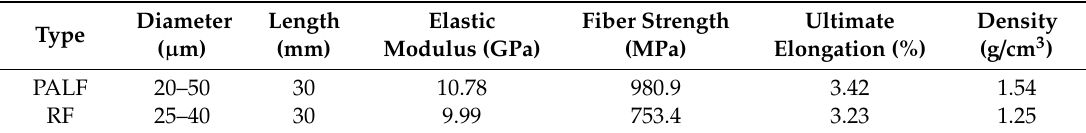
Table 3. Properties of fibers.